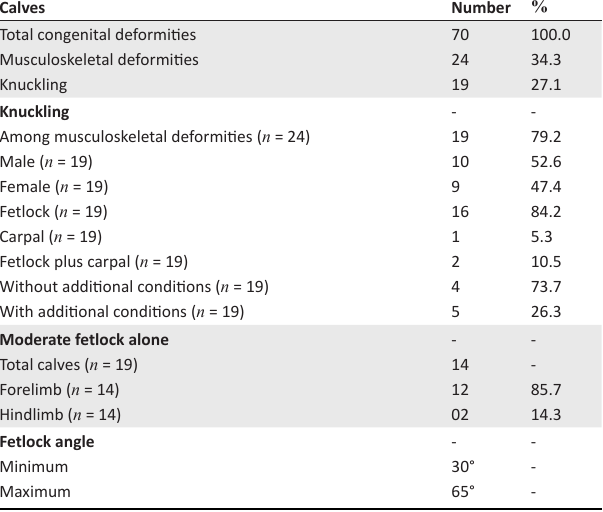
TABLE 2: Outcome of treatment in neonatal dairy calves with moderate fetlock knuckling. Limbs